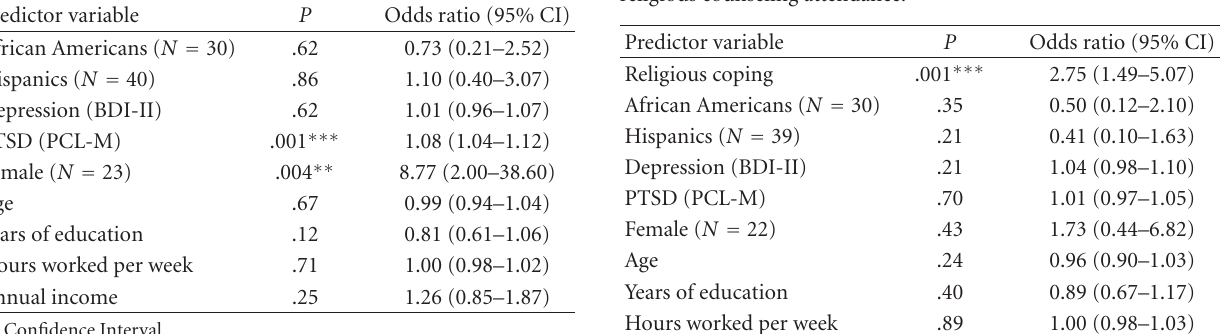
Table 7: Logistic regression with religious coping as a predictor of religious counseling attendance.